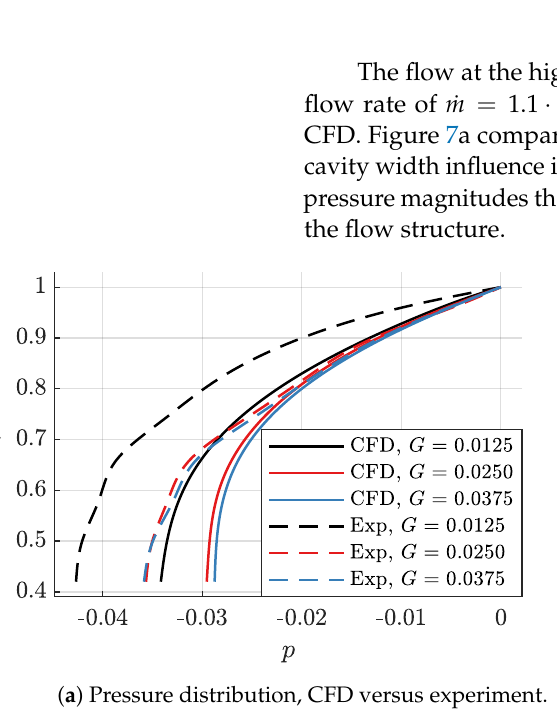
Figure 7. Radial distribution of pressure and fluid rotation factor at the Reynolds number of Re = 2.5 · 10 8 , through-flow mass flow rate of ˙ m = 1.1 · 10 − 3 and at different cavity widths.